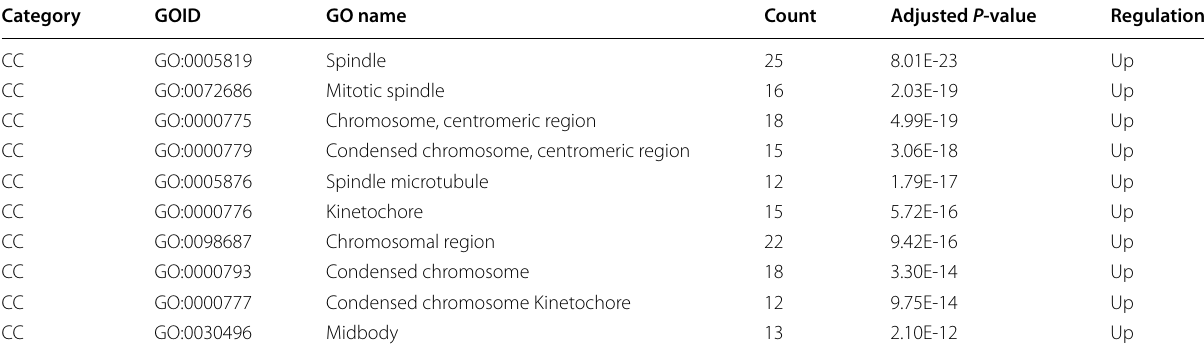
Table 1 The top enriched cell component of DEGs in the daily alcohol user group group sorted by adjusted P-values in a descending order Category